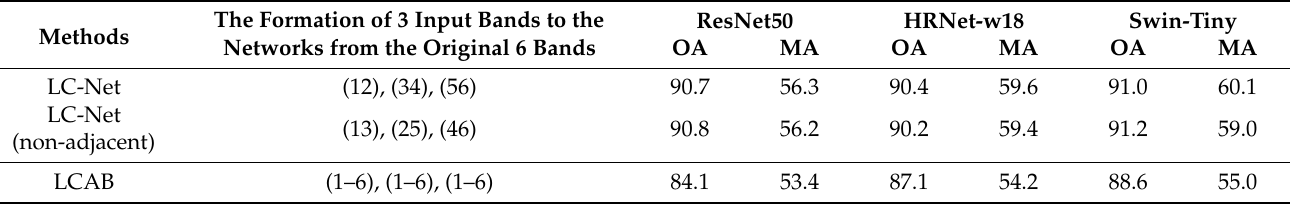
Table 6. Performance of LC-Net and LCAB